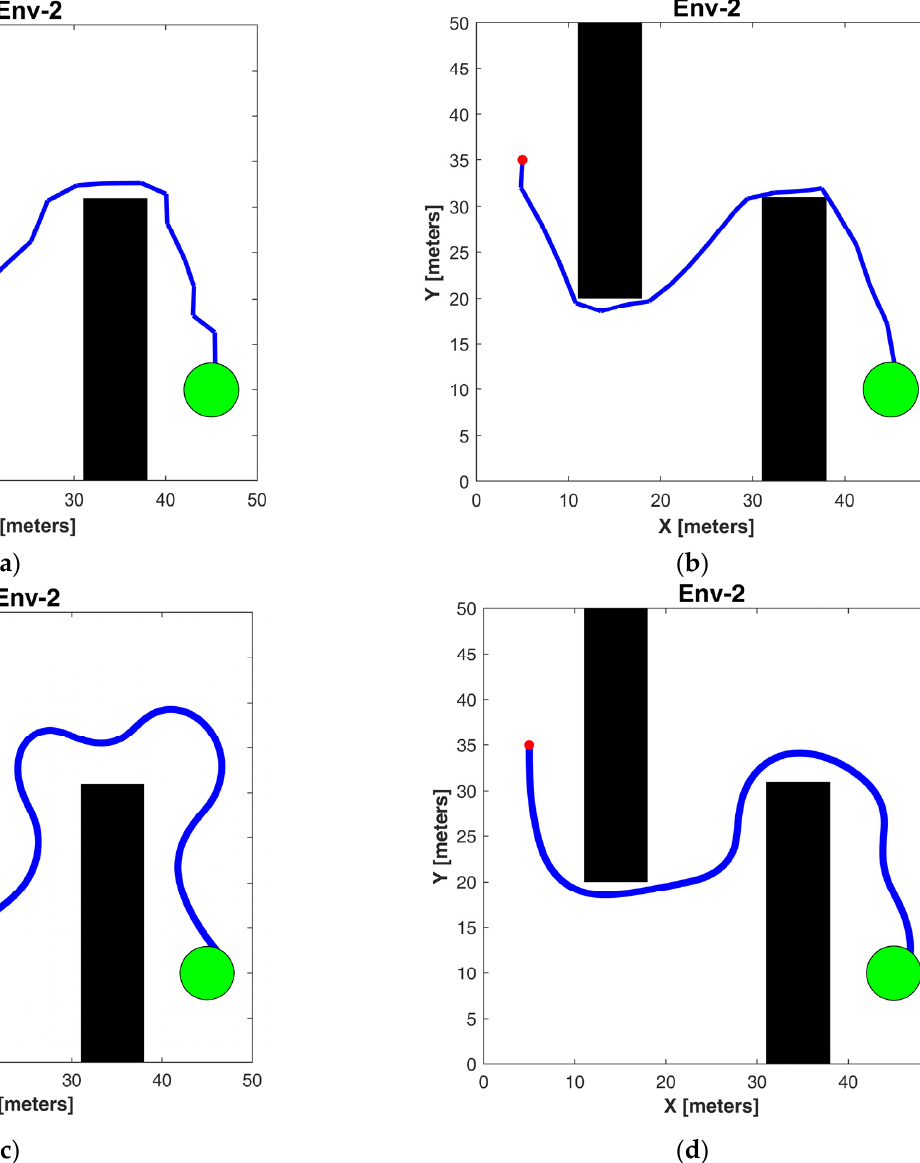
Figure 9. Results of path under scenario 2: ( a ) RRT*; ( b ) Informed ‐ RRT*; ( c ) spRRT; ( d ) spRRT ‐ In ‐ formed.